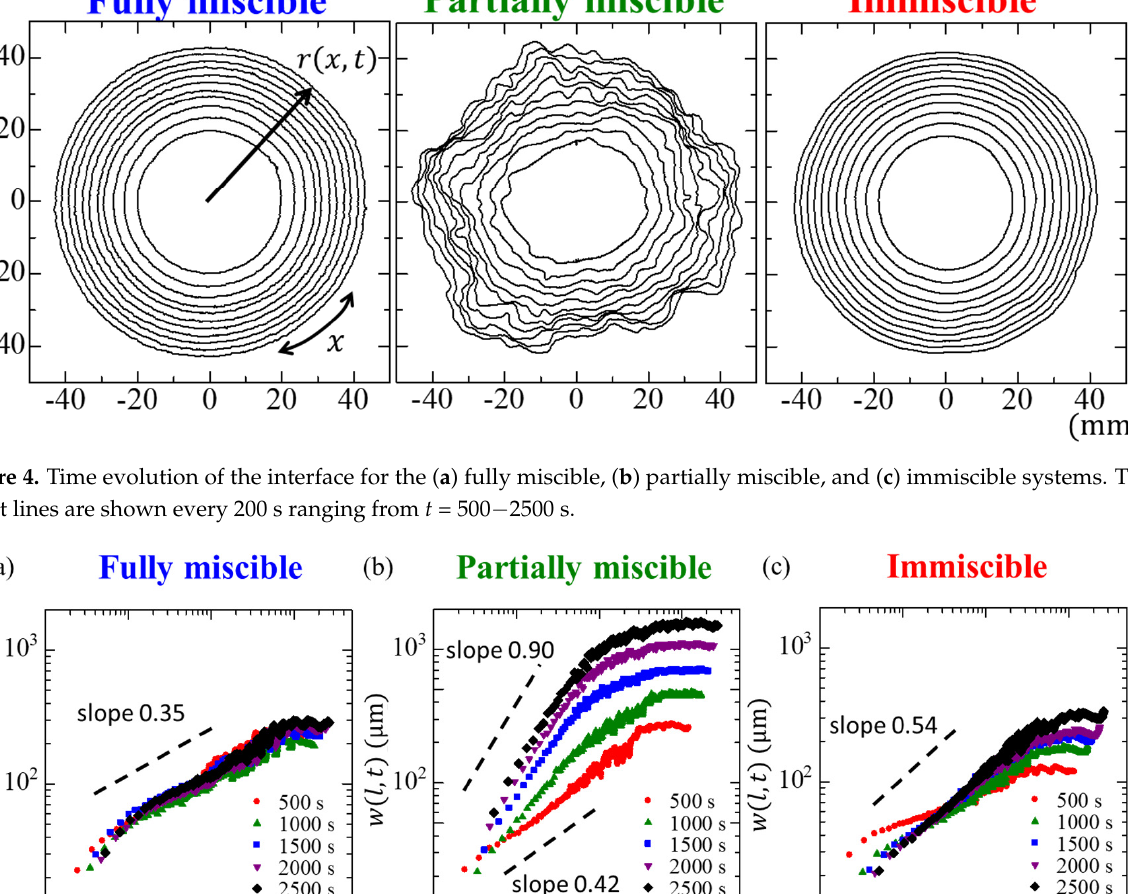
Figure 4. Time evolution of the interface for the ( a ) fully miscible, ( b ) partially miscible, and ( c ) immiscible systems. The result lines are shown every 200 s ranging from t = 500 − 2500 s.